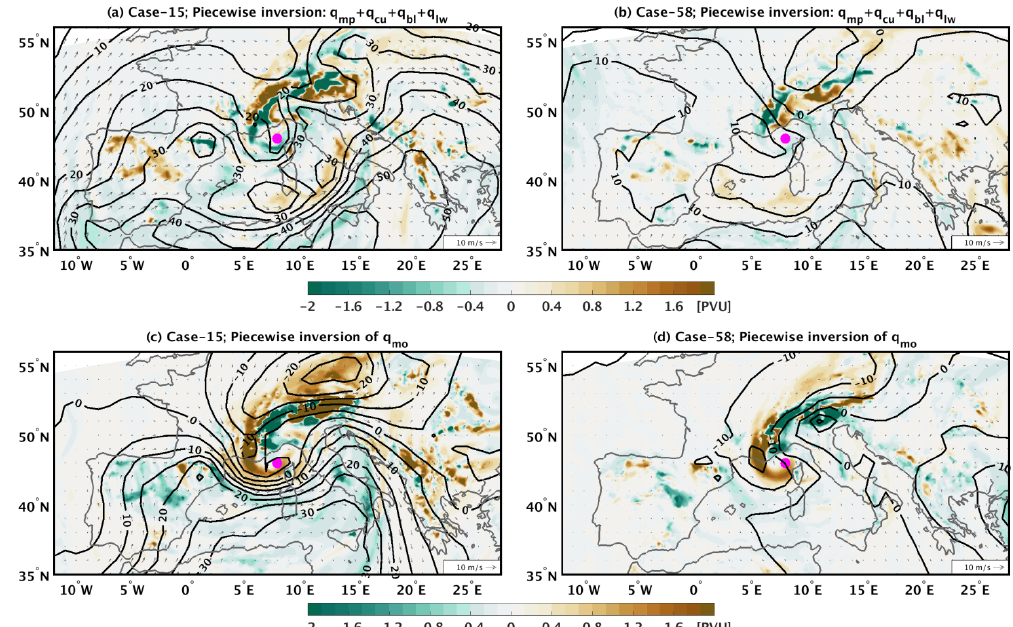
Figure 15. (a) The field of q mp + q cu + q bl + q lw at 850hPa ( in colour ) and the balanced wind ( in arrows ) and geopotential height ( in contours ) fields at 850hPa after inverting q mp + q cu + q bl + q lw for the case no. 15. (b) As in (a) but for case no. 58. (c) The field of q mo at 850hPa ( in colour ) and the balanced wind ( in arrows ) and geopotential height ( in contours ) fields at 850hPa after inverting q mo , for the case no. 15. (d) As in (c) but for case no.